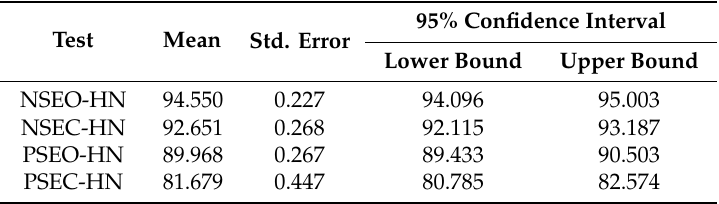
Table 4. Healthy controls’ postural stability scores head neutral mCTSIB.